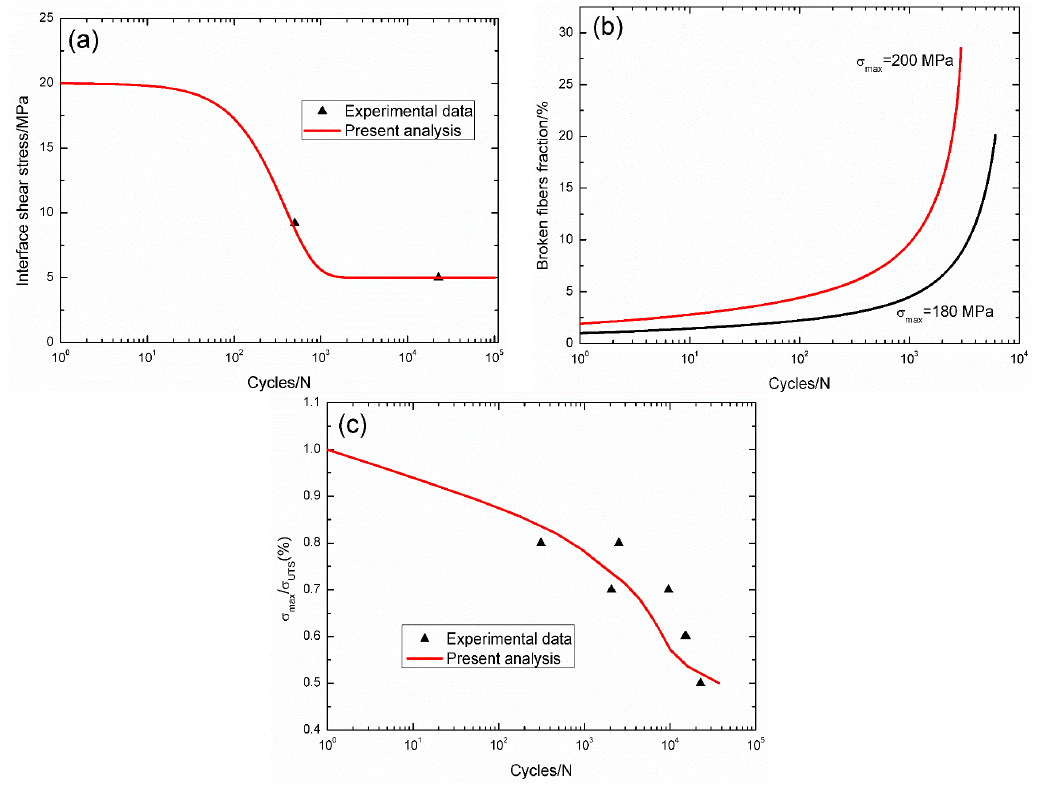
Figure 13. ( a ) The interface shear stress versus applied cycles; ( b ) the broken fiber fraction versus applied cycles; and ( c ) the fatigue life S–N curves of experimental data and theoretical analysis for 2.5D C/SiC composite at 800 °C in air.